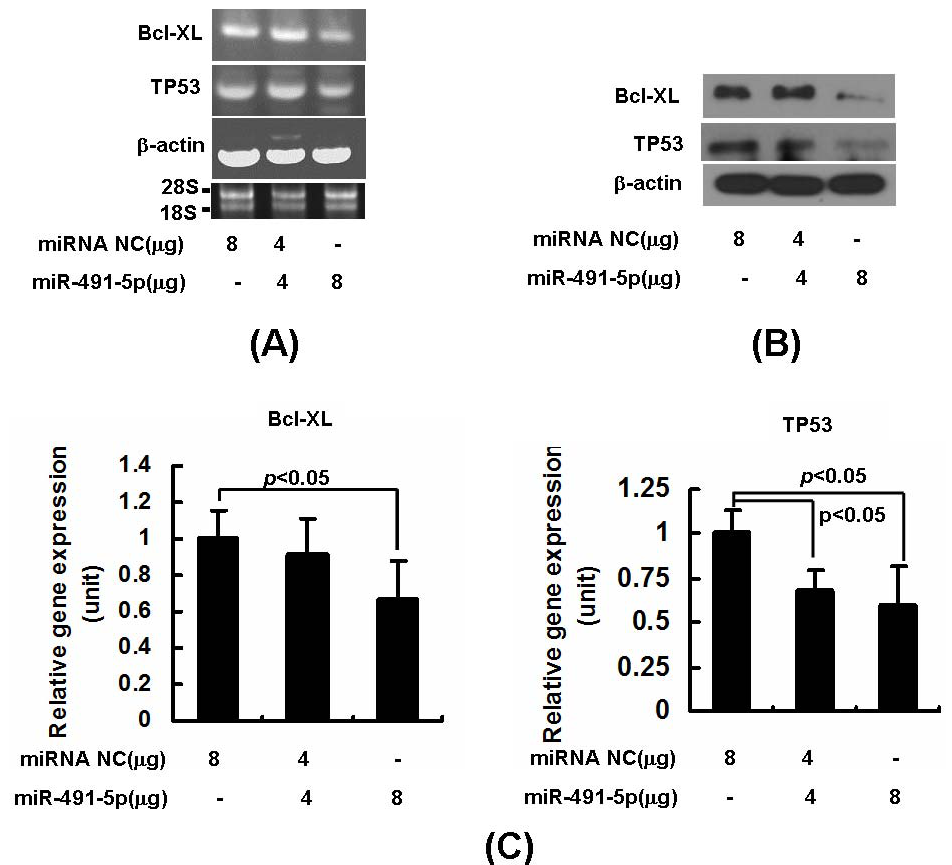
Figure 3. The down-regulation of the targeted gene expressions by chemically synthesized miR491-5p in SW1990 cells. ( A ) Semi-quantitatative RT-PCR analysis on endogenous Bcl-xL and TP53 mRNA expressions was performed after transfecting SW1990 cells with increased doses of miR491-5p. The integrity of RNA samples was assessed by gel electrophoresis to visualiz the presence of 18S and 28S ribosomal RNAs; ( B ) Western blot analysis on miR491-5p transfected SW1990 cells. The reaction products were probed with anti-Bcl-XL and anti-TP53 antibodies. Beta-actin expression was served as loading control; ( C ) Real time qRT-PCR analysis on Bcl-xL and TP53 gene expressions was shown after delivering increased doses of miR491-5p into SW1990 cells. Beta-actin gene expression was served as internal control. Data represented as mean ± SD from four independent experiments. The difference was calculated by student  s t test. Significant difference was indicated as p <